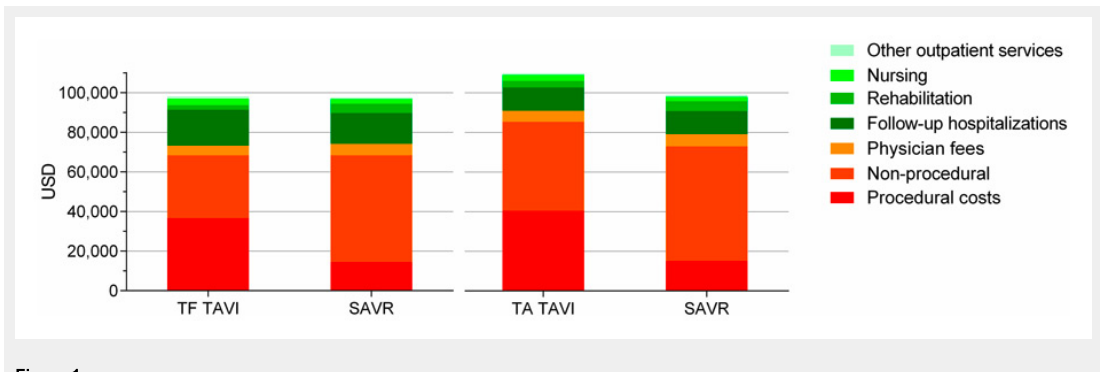
Cumulative 1 year costs of TAVI and SAVR in the PARTNER trial in USD. Procedural costs were generally higher with TAVI, mainly due to the higher costs of the implant and personnel. However, non-procedural costs were lower with TAVI, mainly due to the shorter hospitalisation period. TAVI = transcatheter aortic valve implantation; TF = transfemoral; SAVR = surgical aortic valve replacement; TA = transapical